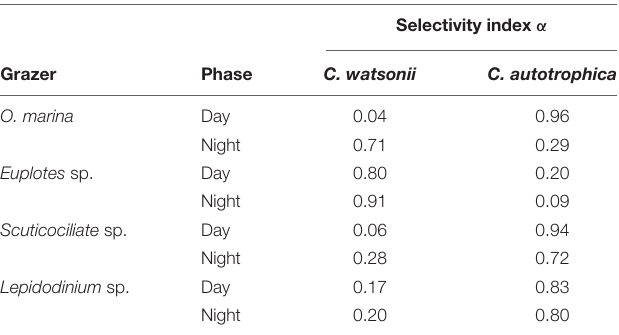
TABLE 2 | Manly–Chesson selectivity index α of grazers feeding on mixed prey C. watsonii and C. autotrophica during daytime and night-time. Selectivity index